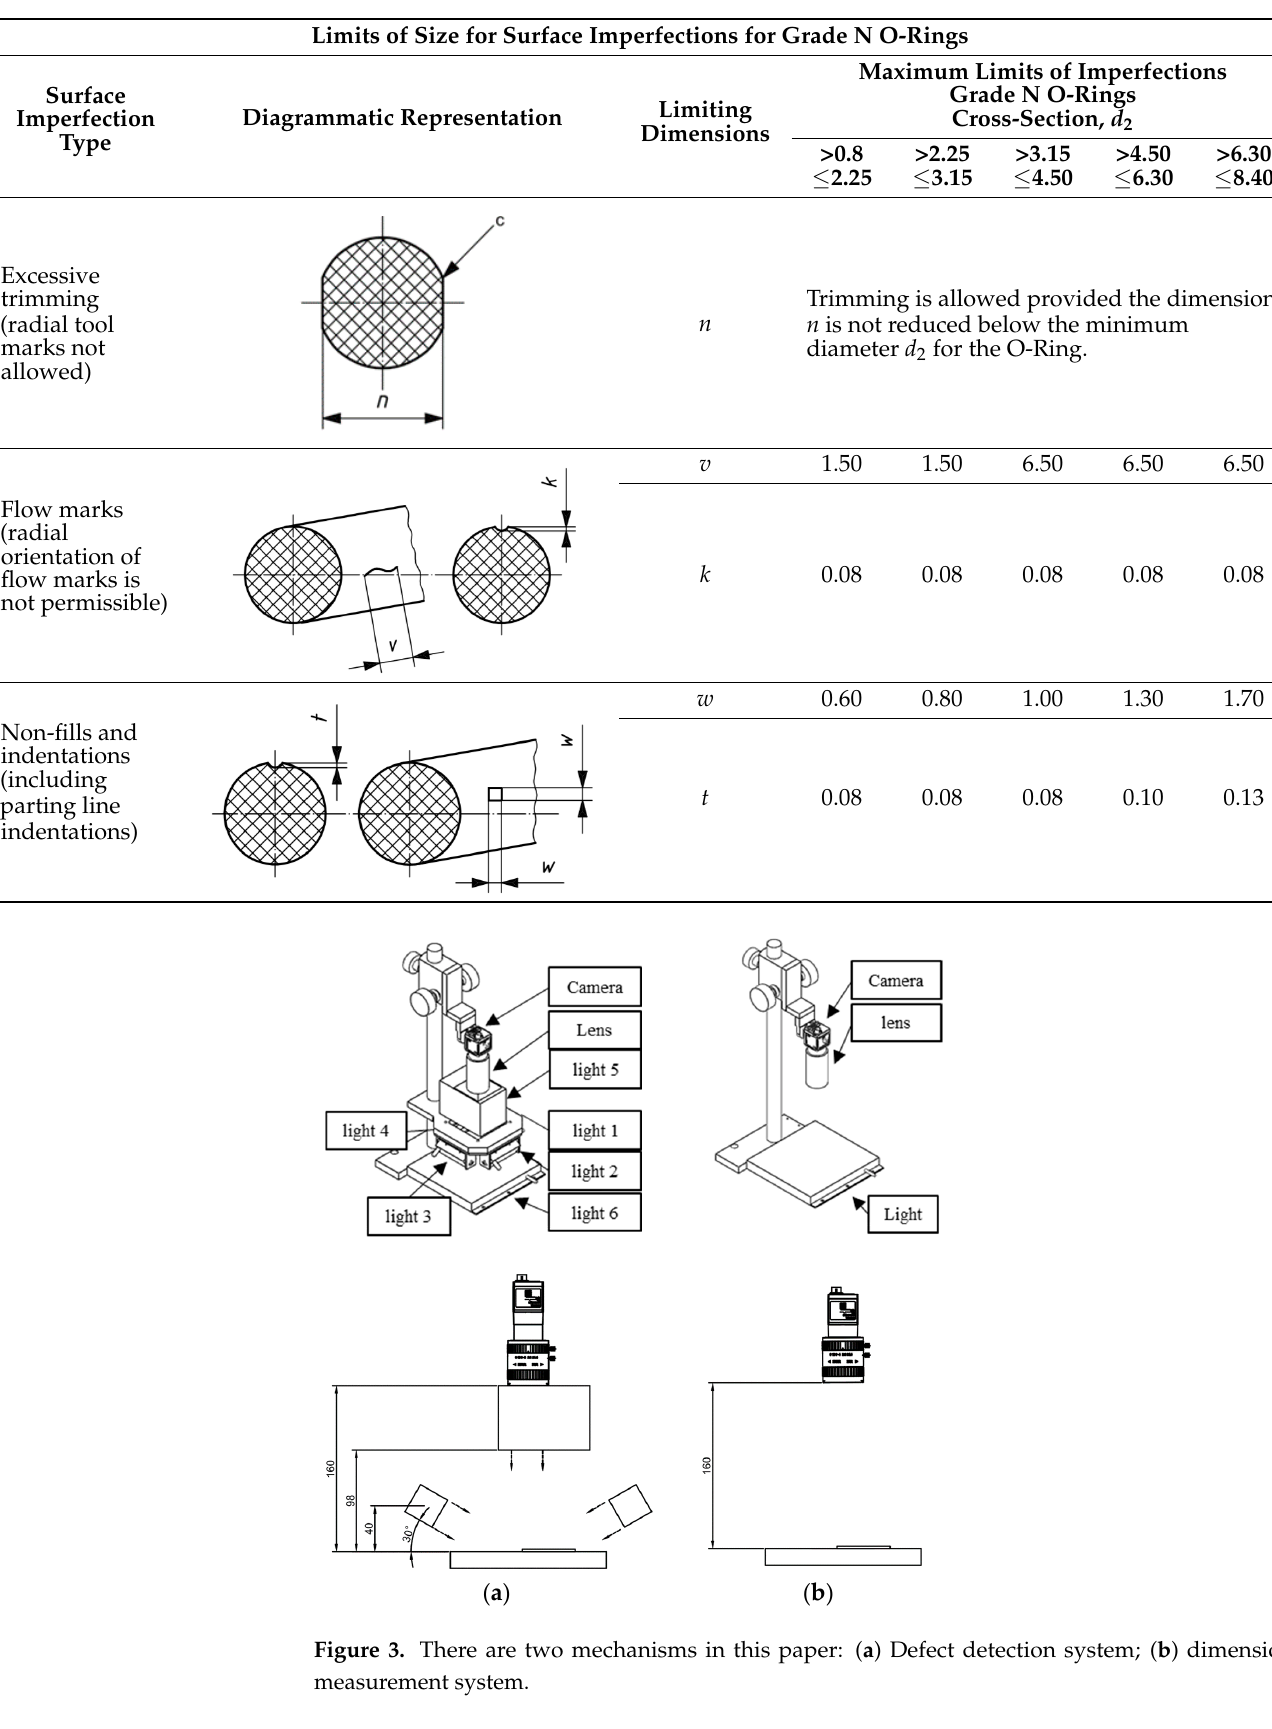
Table 1. ISO 3601-3:2005 O-ring quality acceptance criteria [9].